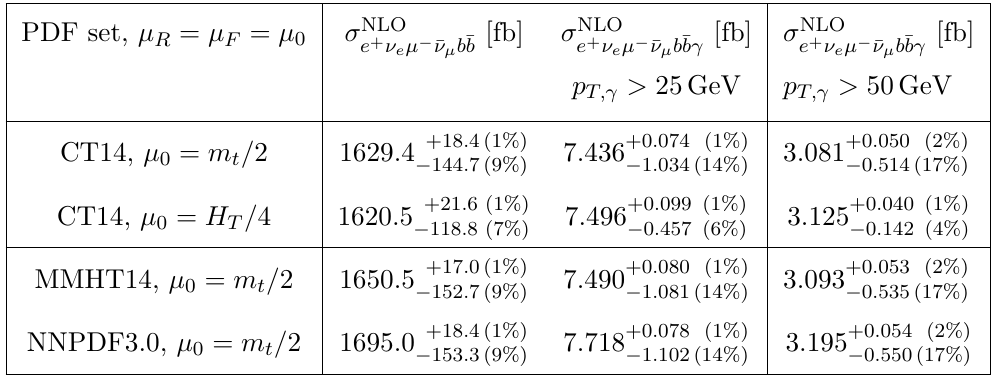
Table 1 . NLO cross sections for pp e + (cid:23) e (cid:22) (cid:0) (cid:22) (cid:23) (cid:22) b (cid:22) b + X and pp e + (cid:23) e (cid:22) (cid:0) (cid:22) (cid:23) (cid:22) b (cid:22) b(cid:13) + X at the LHC ! ! with p s = 13 TeV. Also included are theoretical errors as obtained from the scale variation. In the case of pp e + (cid:23) e (cid:22) (cid:0) (cid:22) (cid:23) (cid:22) b (cid:22) b(cid:13) + X results for two di(cid:11)erent values of the p T;(cid:13) cut are given. Various ! PDF sets are